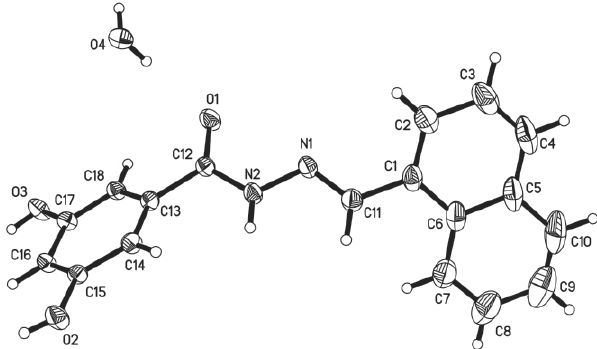
Table 1. Data collection and handling.